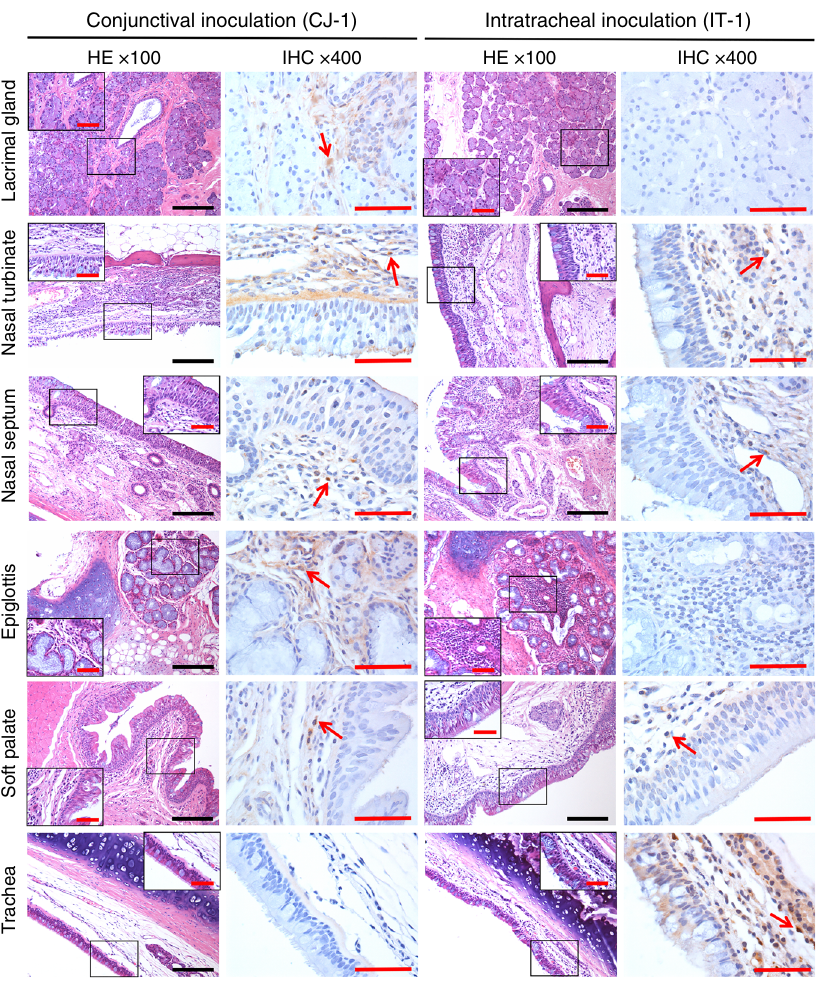
Fig. 4 The distinct viral distributions in CJ-1 and IT-1 were consistent with anatomical structure. Organs and tissues from the nasolacrimal system and conductive system of the respiratory tract, including the lacrimal gland, nasal turbinate, nasal septum, epiglottis, soft palate, and trachea, were examined. Sequential sections were stained with H&E and subjected to IHC. Fields in the H&E images outlined in black are magni fi ed. The IHC images show the same fi eld outlined in black at ×400 magni fi cation. Black scale bar = 100 µ m, red scale bar = 50 µ m. Data are representative of three independent